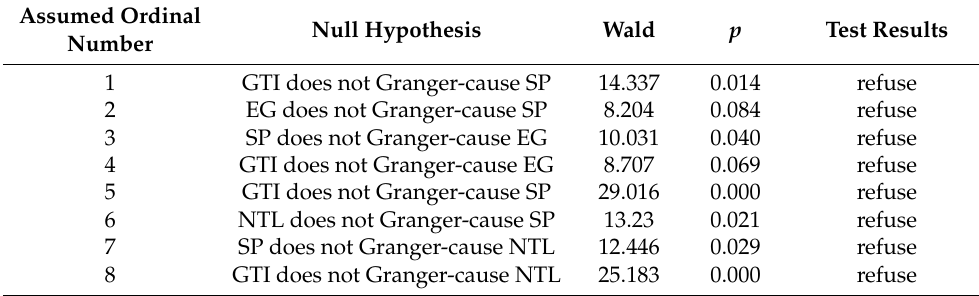
Table 2. Granger causality test of